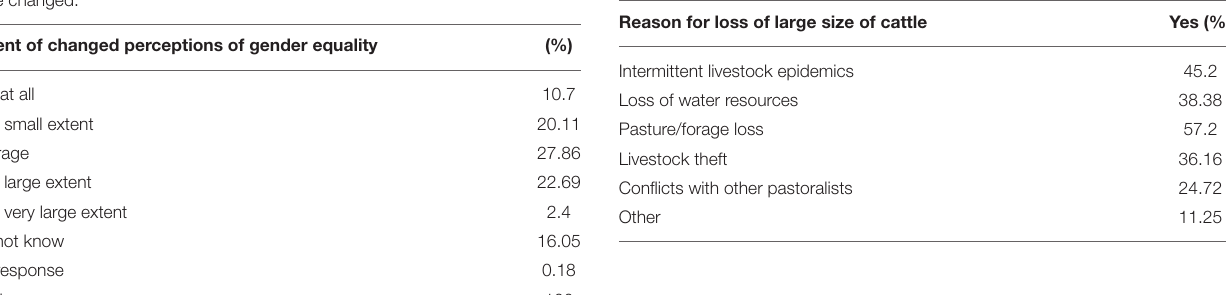
TABLE 4 | Reasons cited for the cause of large-scale deaths of